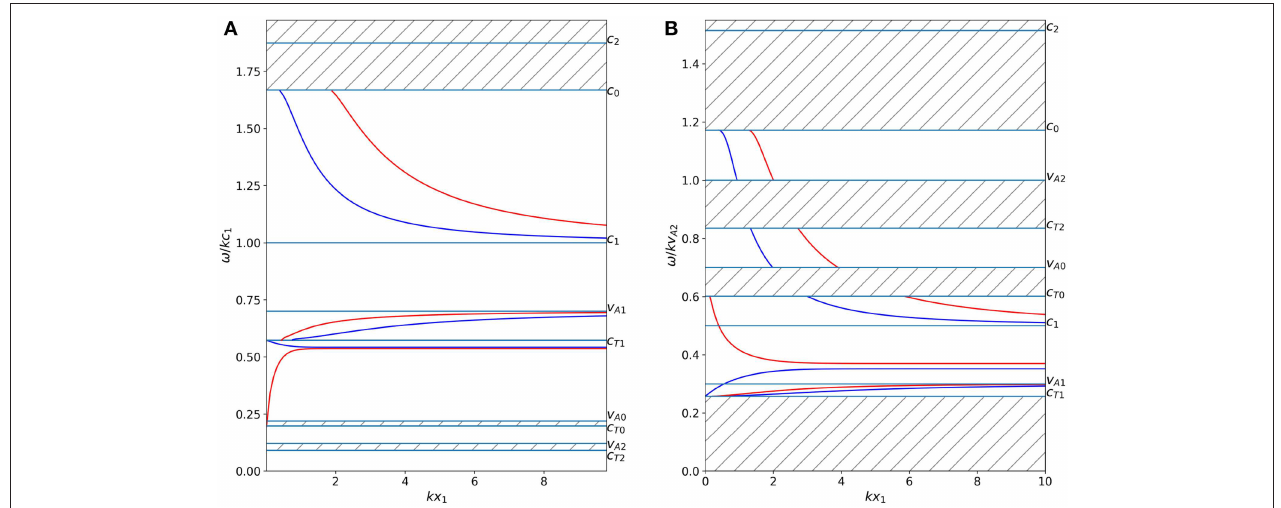
FIGURE 8 | Solutions to the dispersion relation for high- β cases. (A) Slow and fast mode body waves, as well as slow surface waves are present when v A 1 0.7 c 1 , = v A 0 0.2 c 1 , v A 2 0.1 c 1 , c 0 1.6683 c 1 , c 2 1.8742 c 1 , ρ 0 /ρ 1 0.5, ρ 2 /ρ 1 0.4. (B) Three bands of fast body modes, one band of slow body modes, and a = = = = = = pair of slow surface modes exist when v A 1 0.2 v A 2 , v A 0 0.7 v A 2 , c 1 0.5 v A 2 , c 0 1.1 v A 2 , c 2 1.8 v A 2 , ρ 0 /ρ 1 0.2008, ρ 2 /ρ 1 0.1163. In each panel, only = = = = = = = a couple of examples in each band of body modes are displayed. Blue (red) curves illustrate quasi-sausage (quasi-kink) modes. No trapped oscillations exist in the hatched regions.